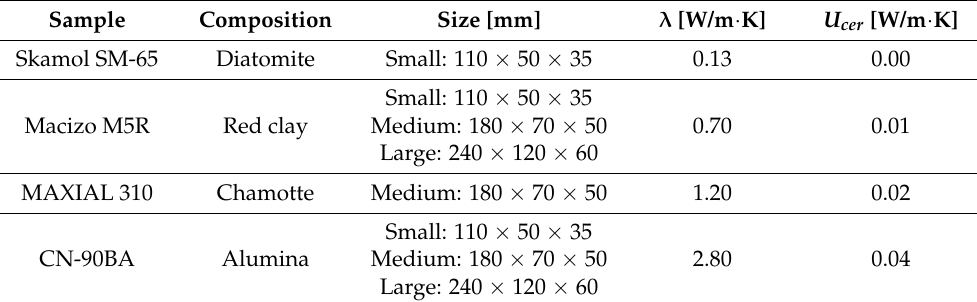
Table 1. Commercial samples features used in validation and